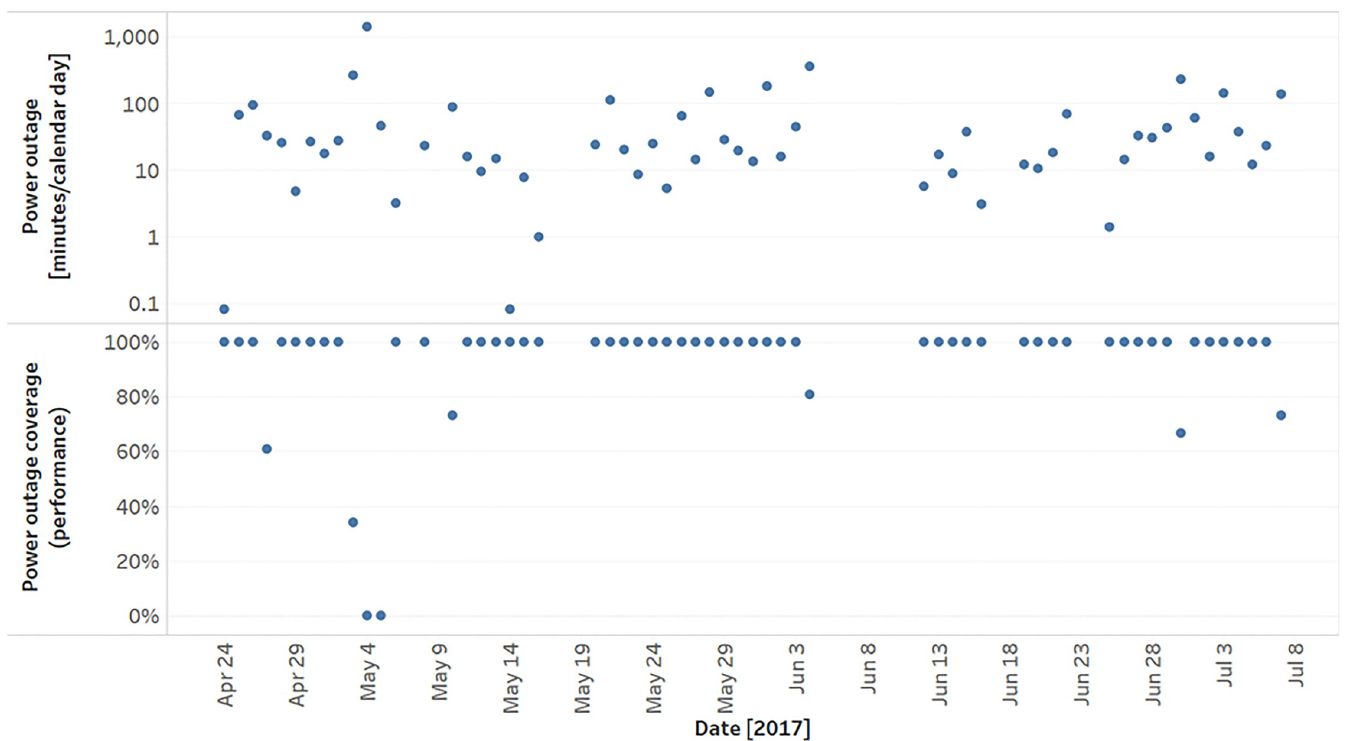
Fig 5. Daily power outage duration and associated low-pressure reservoir system performance. (A) Cumulative power outage minutes per calendar day. (B) Low- Pressure Reservoir system power outage coverage shown for each day.